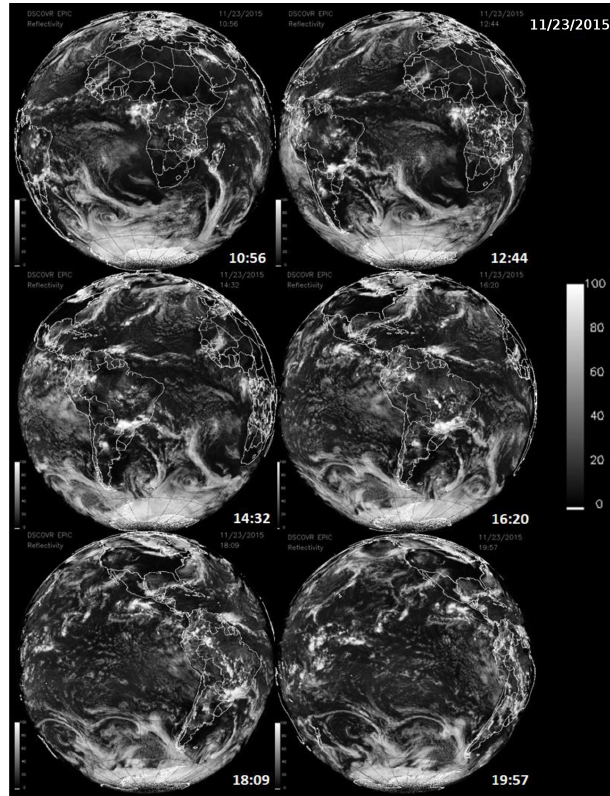
Figure 6. Cloud formations from 23 Nov 2015 showing cloud cover in the Southern Hemisphere and near Antarctica at six different times: 10:56, 12:44 14:32, and 16:20, 14:32, 18:09, and 19:57 UTC.